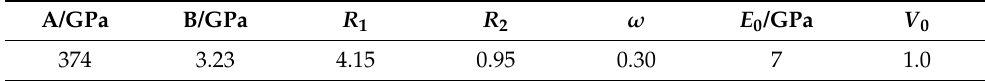
Table 5. TNT explosive equation of state